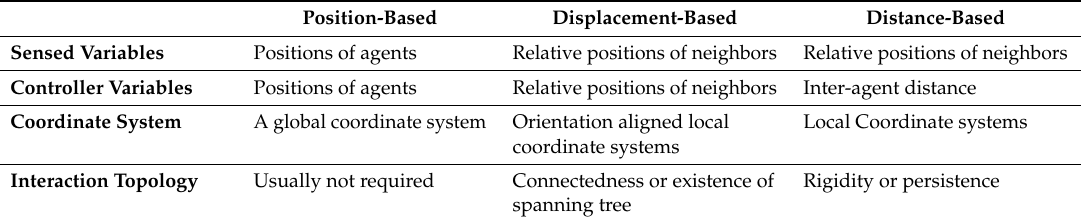
Position-Based Displacement-Based Distance-Based Sensed Variables Positions of agents Relative positions of neighbors Relative positions of neighbors Controller